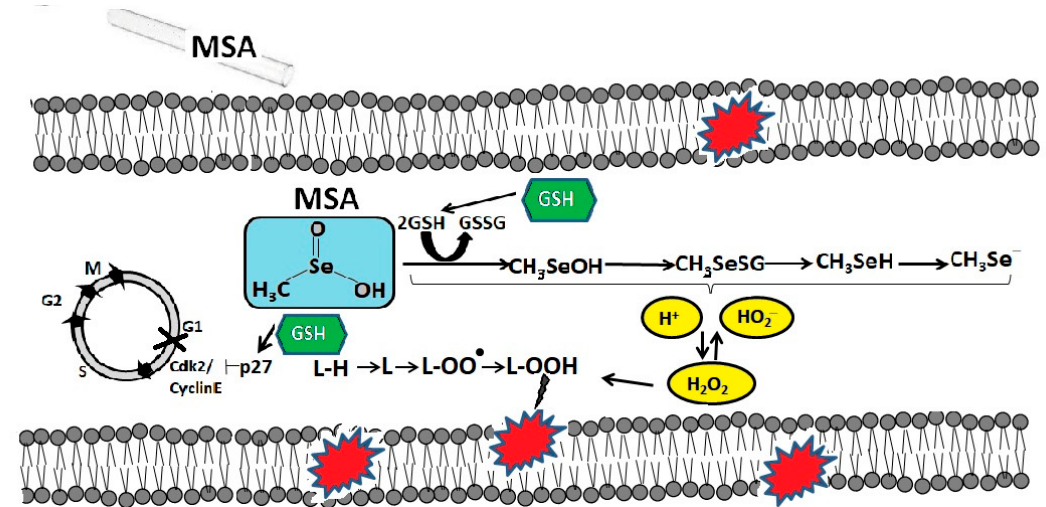
Figure 2. The molecular mechanisms of MSA cytotoxicity mediated by intracellular glutathione in cancer cells. Reduced glutathione (GSH), present in cancer cells in large amounts, is extremely important for the metabolism of MSA. In the process of converting MSA into methylselenol, glutathione is oxidized (GSSG) and free radicals, in particular, hydrogen peroxide, increase, which are the cause of the oxidative degradation of membrane lipids. In addition, MSA, through the oxidation of GSH, contributes to the G1 arrest of the cell cycle by suppressing the activity of cyclin E1 and activating the cyclin-dependent kinase 2 inhibitor p27Kip1.